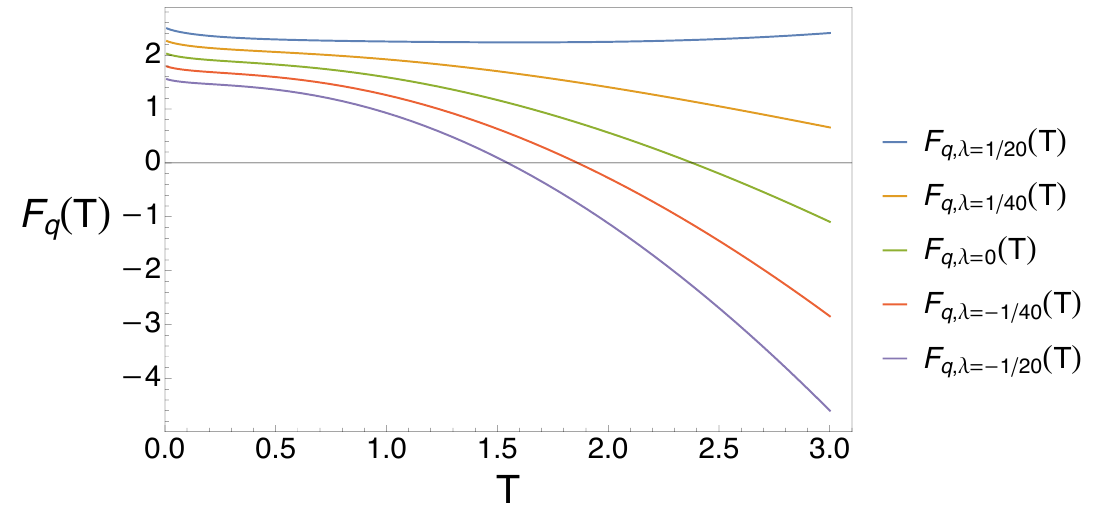
Figure 4. We plot the quenched free energy F q,λ ( T ) for the deformed Airy model as a function of temperature T . We notice that a deformation with the good sign λ < 0 lowers the quenched free energy while the one with the bad sign λ > 0 increases F monotonically decreases as T increases for T < 1 ; however, for the good sign of λ , this breaks down for λ = 1 / 20 and at around T = 1 . Notice that the perturbative expansion of λ always appears as λT . In order for the first order approximation to hold, λT should be small. Therefore, this breakdown of monotonicity when T becomes large is likely due to the fact that we go beyond the validity of perturbation